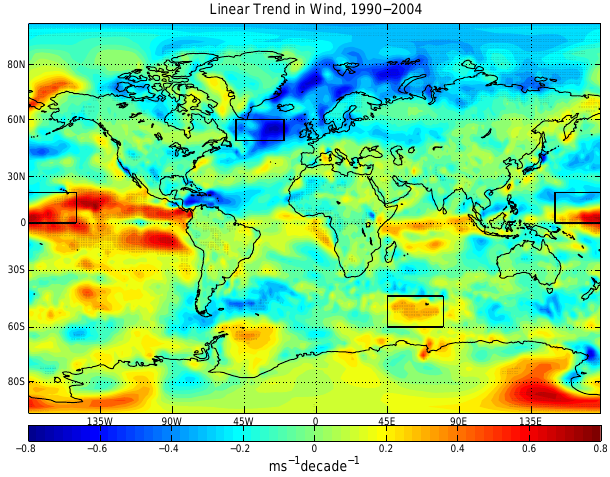
Figure 1. Linear trend in ERA-Interim 10m wind speeds for the years 1990–2004. Stippling shows the areas where the linear trend is statistically significantly different from